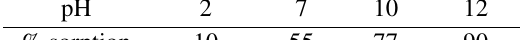
pH 2 7 10 12 % sorption 10 55 77 90 *Adsorbent = 1.0 g of activated carbon (granulated form), Adsorbate= 10 mL of 25 ppm, Flow rate = 2 mL min -1 .